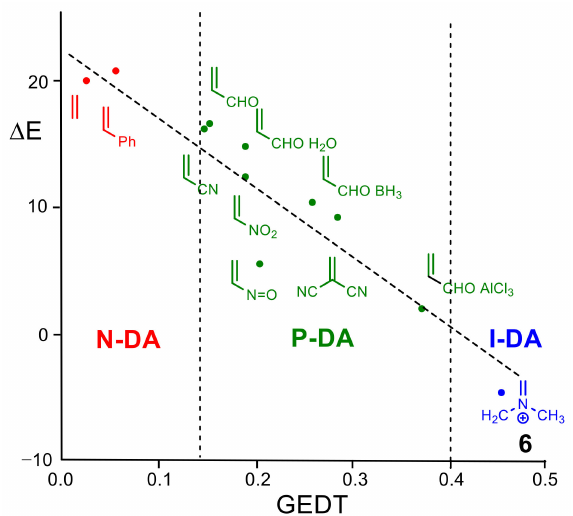
Figure 1. Plot of the activation barriers ( ∆ E in kcal · mol − 1 ) vs. the GEDT, e, R 2 = 0.89, for the DA reactions of Cp 1 with the substituted ethylene series of an increased electrophilic character. The classification of the DA reactions, based on the GEDT, is